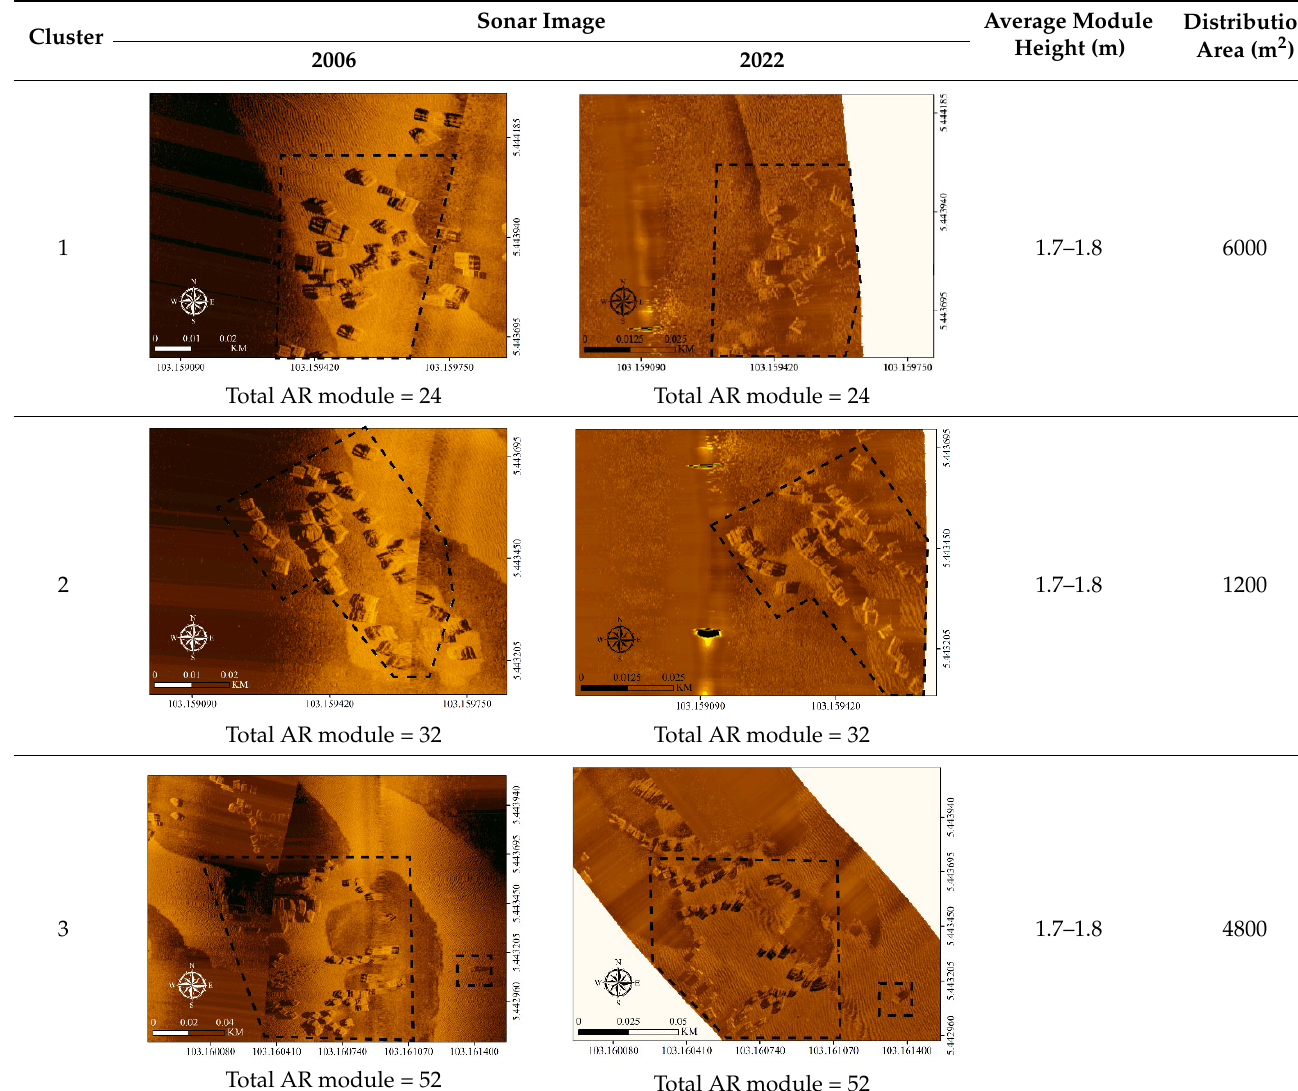
Table 2. Mosaicked sonar imagery of BK AR from 2006 and 2022 survey. The bounding box (black dotted lines) indicates the area that the BK AR can be confidently crosschecked between the two surveys.